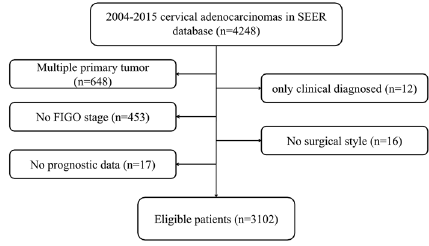
Figure 1. Flow chart of patient